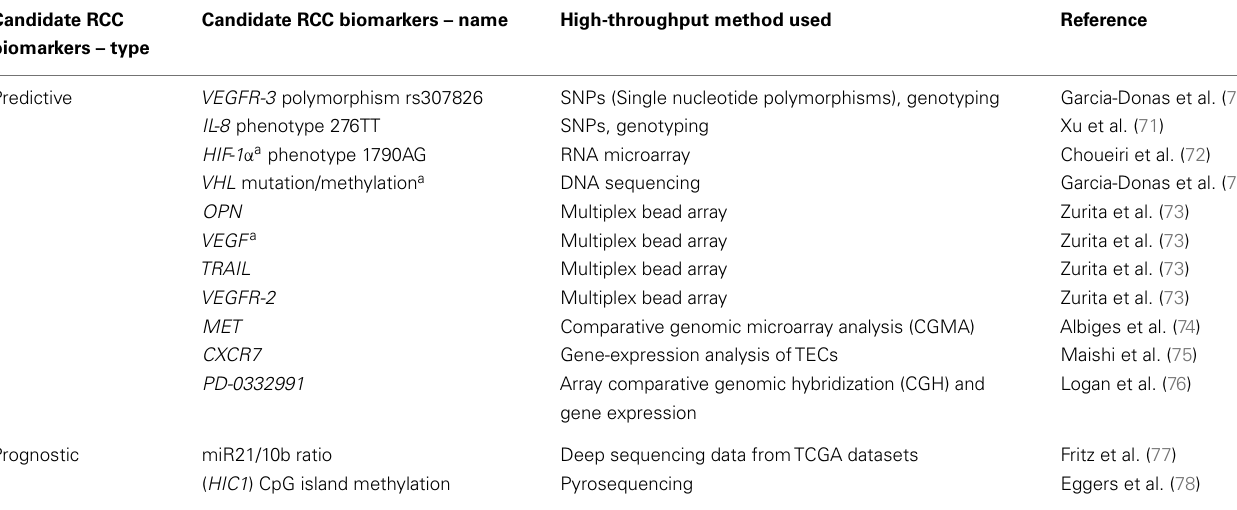
Table 1 | Chosen RCC prognostic and predictive biomarkers, which have been discovered as a result of high-throughput genomic research conducted up to date